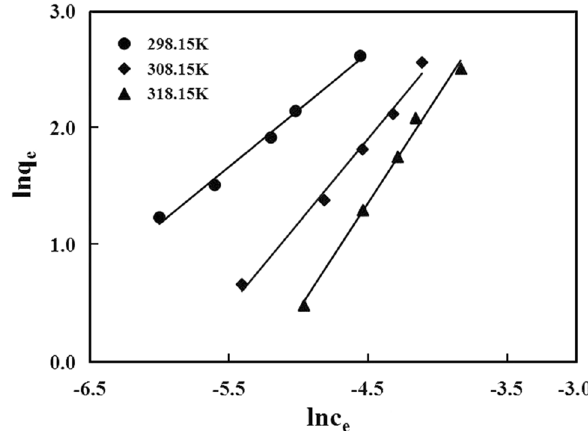
Fig. 4 Freundlich adsorption